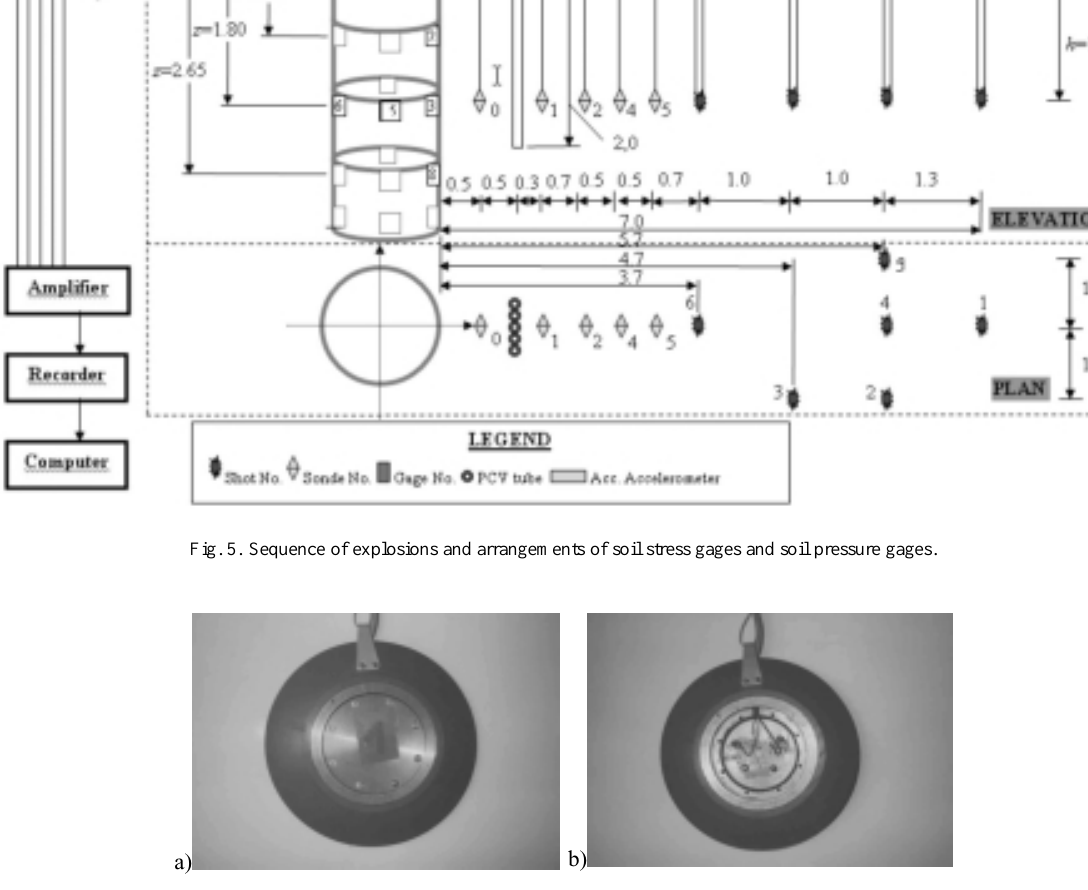
Fig. 6. Soil stress gage of diaphragm type with epoxy ring around its perimeter and rope to its suspension: a) view of gage with the plate fixed to the gage casing, b) cavity in casing and diaphragm instrumented with semiconductor strain